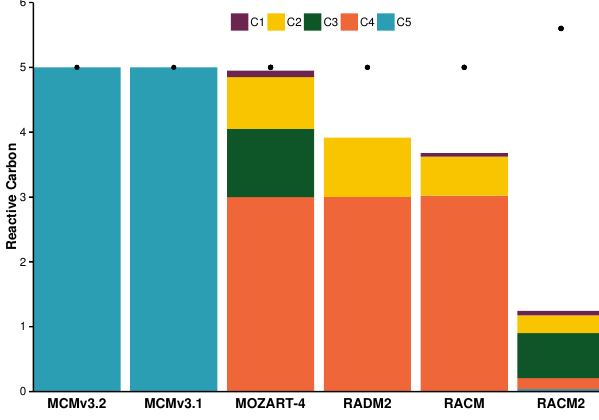
Figure 6. The distribution of reactive carbon in the products of the reaction between NO and the pentyl peroxy radical in lumped- molecule mechanisms compared to the MCM. The black dot repre- sents the reactive carbon of the pentyl peroxy